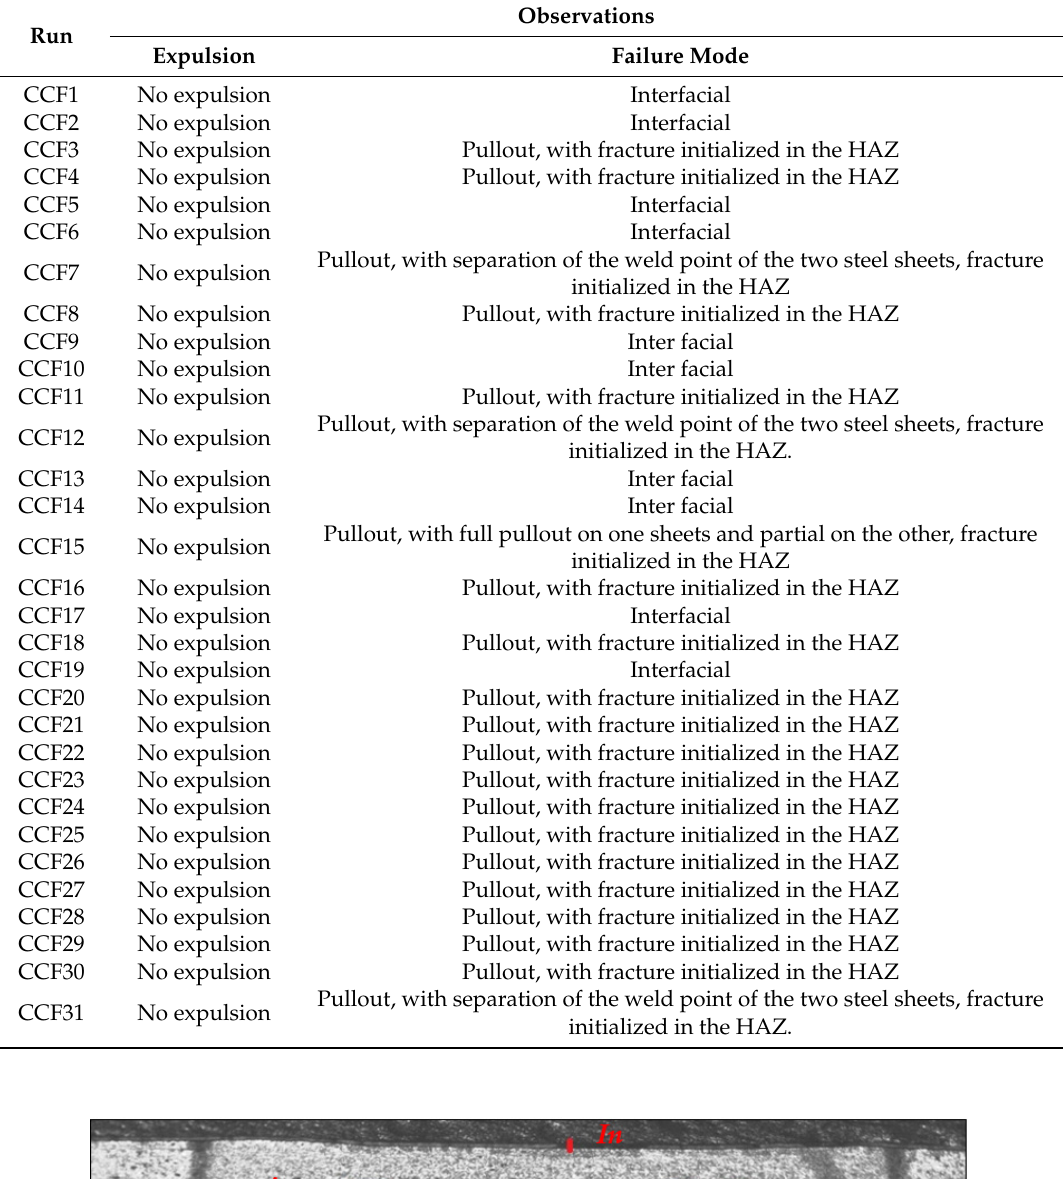
Table 13. Observations after the tensile shear testing.